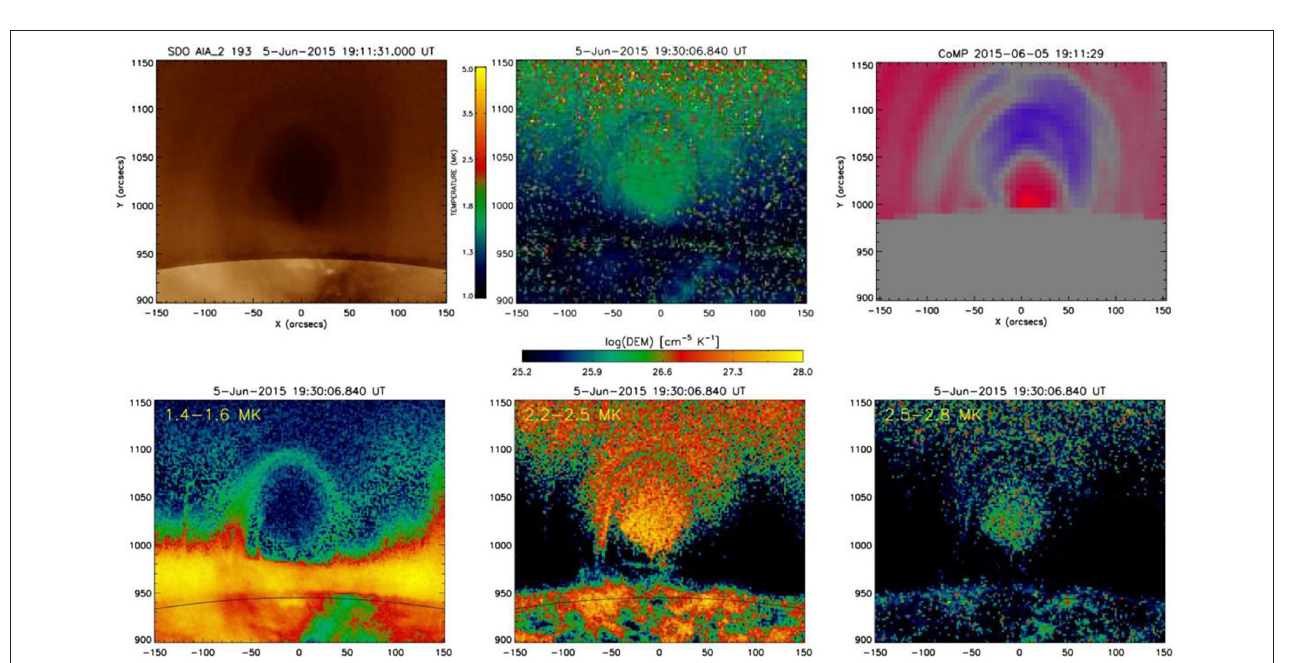
FIGURE 11 | The same as in Figure 10 but for the 2015 June 05 cavity.